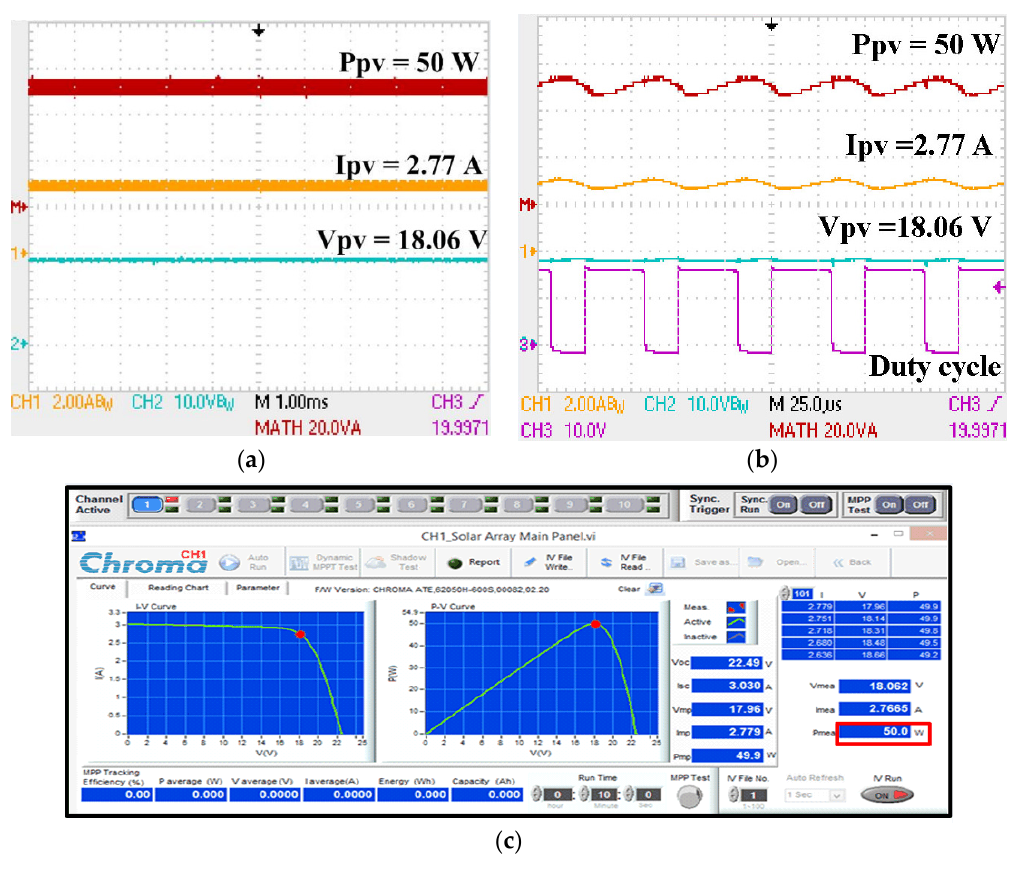
Figure 19. Modified LFO at 1000 W/m 2 , ( a ), ( b ), ( c ) reflect same result.